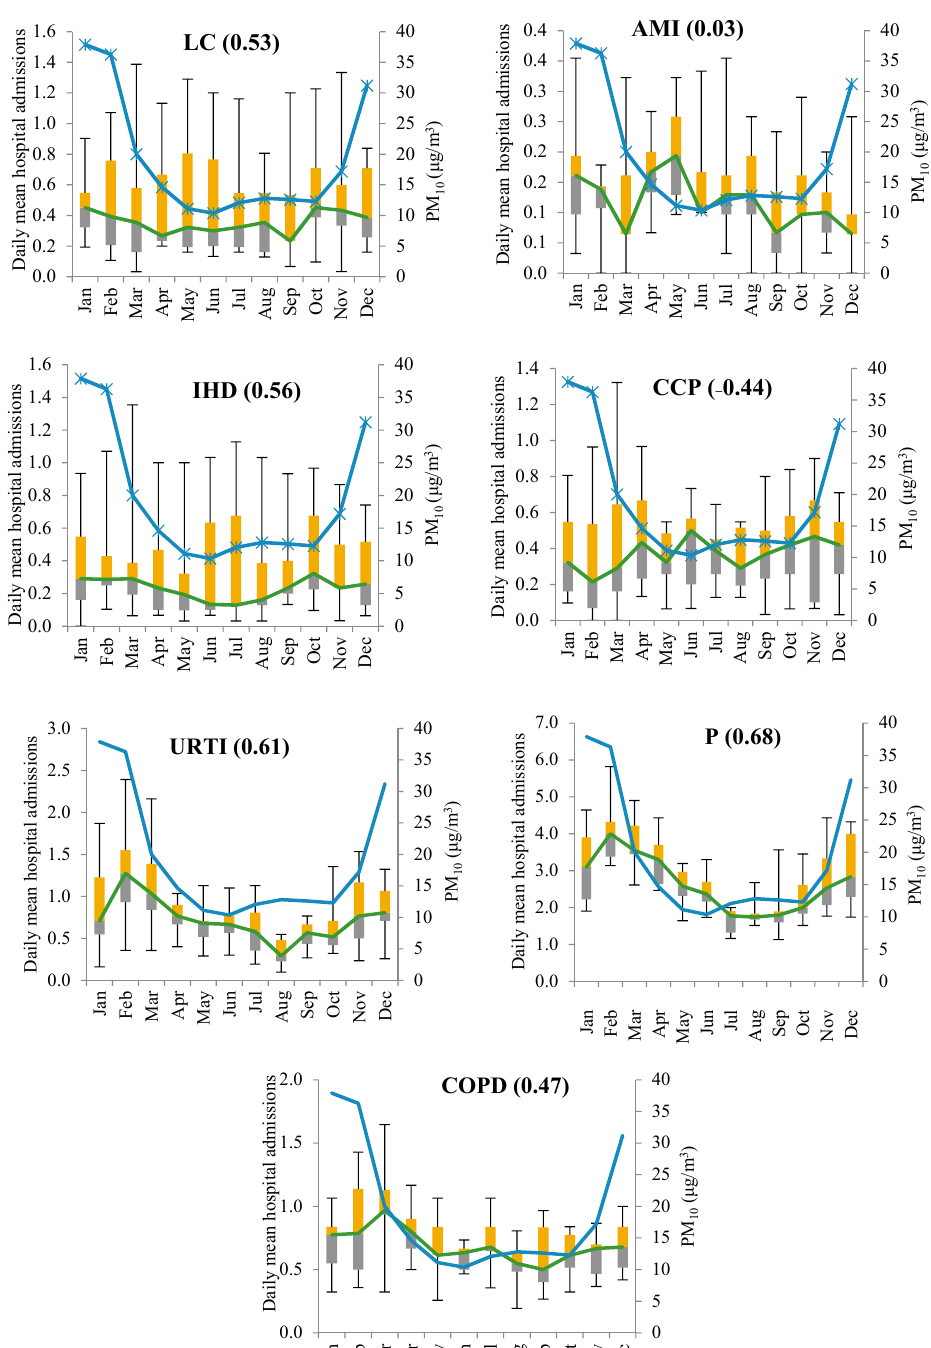
Figure 10. Box-plot analysis of daily mean hospital admissions. The lower (grey) and upper (yellow)